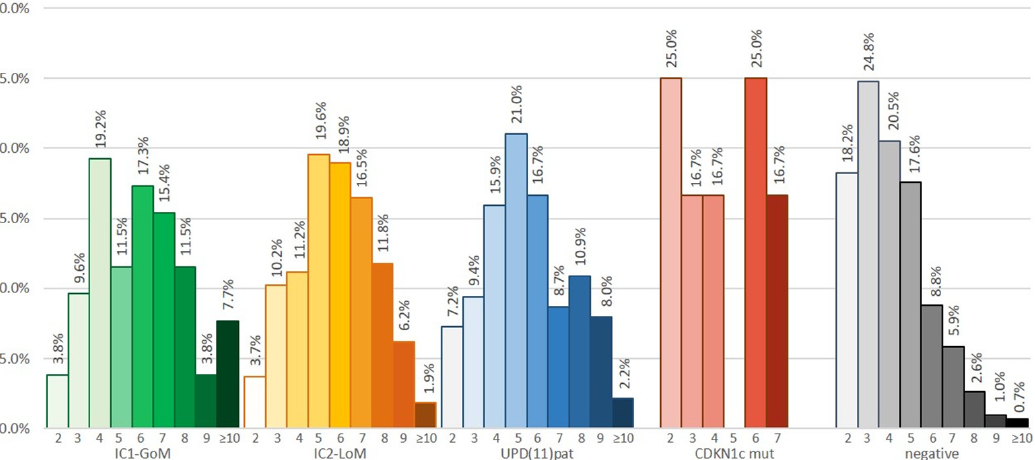
Figure 2. Molecular subgroups per each point of the consensus score [10]. Percentages of the negative cases (in gray) refer to the total. Percentages in the four subgroups refer to the total of positive cases, including gain of methylation at imprinting center 1 (IC1 ‐ GoM, in green), loss of methylation at imprinting center 2 (IC2 ‐ LoM in orange), paternal uniparental disomy of the 11p15.5 chromosomal region (UPD(11)pat, in blue), and pathogenic variants in CDKN1C ( CDKN1c mut, in red).